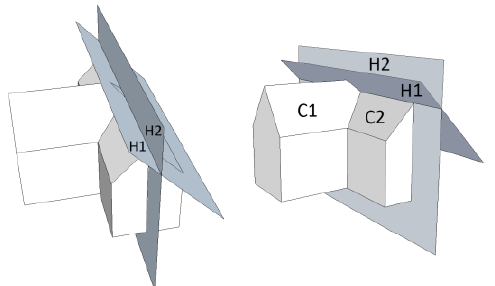
Figure 7. The two half-spaces H1 and H2 from component C2 are used to delimit component C1.